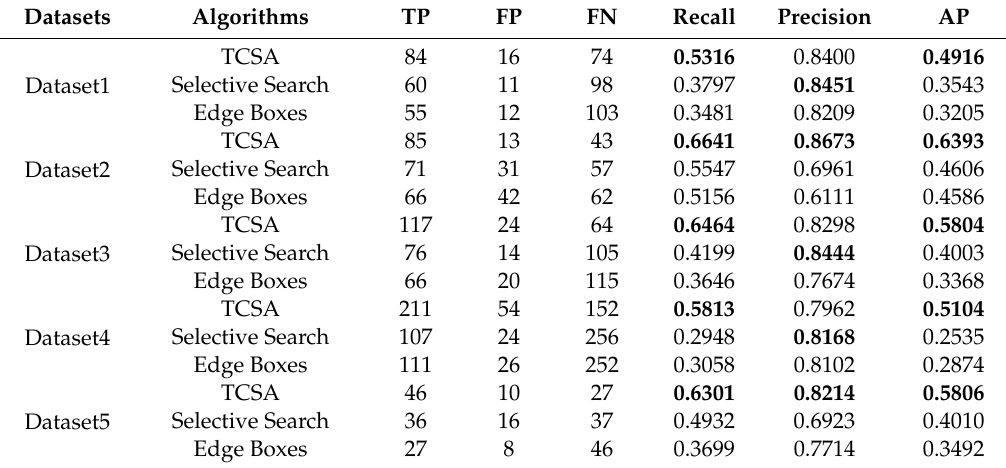
Figure 8. PR (precision-recall) curves of region proposal algorithms in different datasets. The results in datasets 1–5 are shown in ( a – e ). TCSA (tobacco candidate selecting algorithm) is presented as red solid lines, while selective search is presented as blue dotted lines, and edge boxes are presented as green dashed lines. Table 3. The TP (true positive), FP (false positive), FN (false, negative), AP (average precision) of TCSA (tobacco candidate selecting algorithm), selective search and edge boxes.